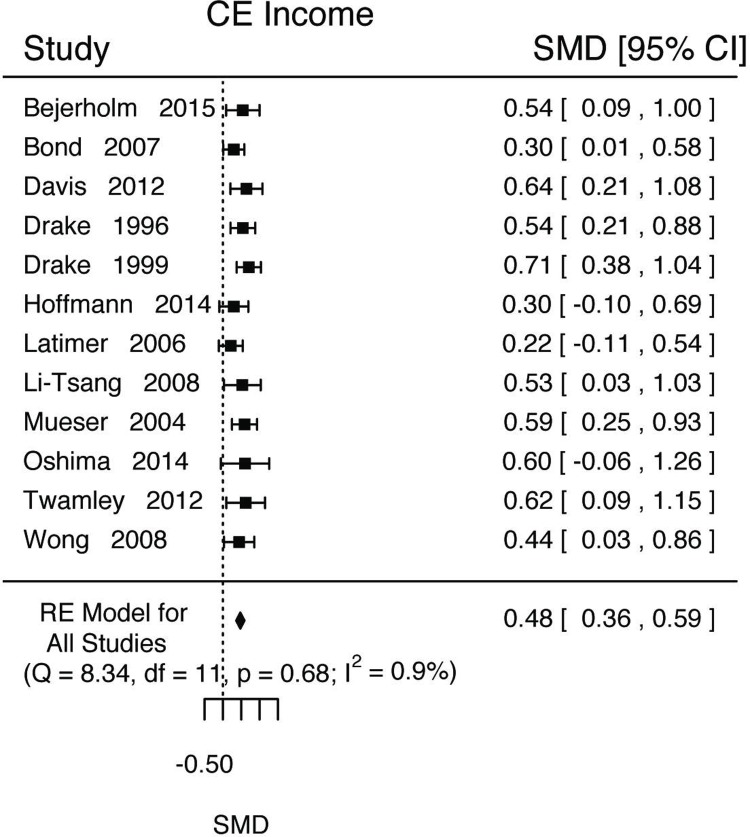
Income outcome results.